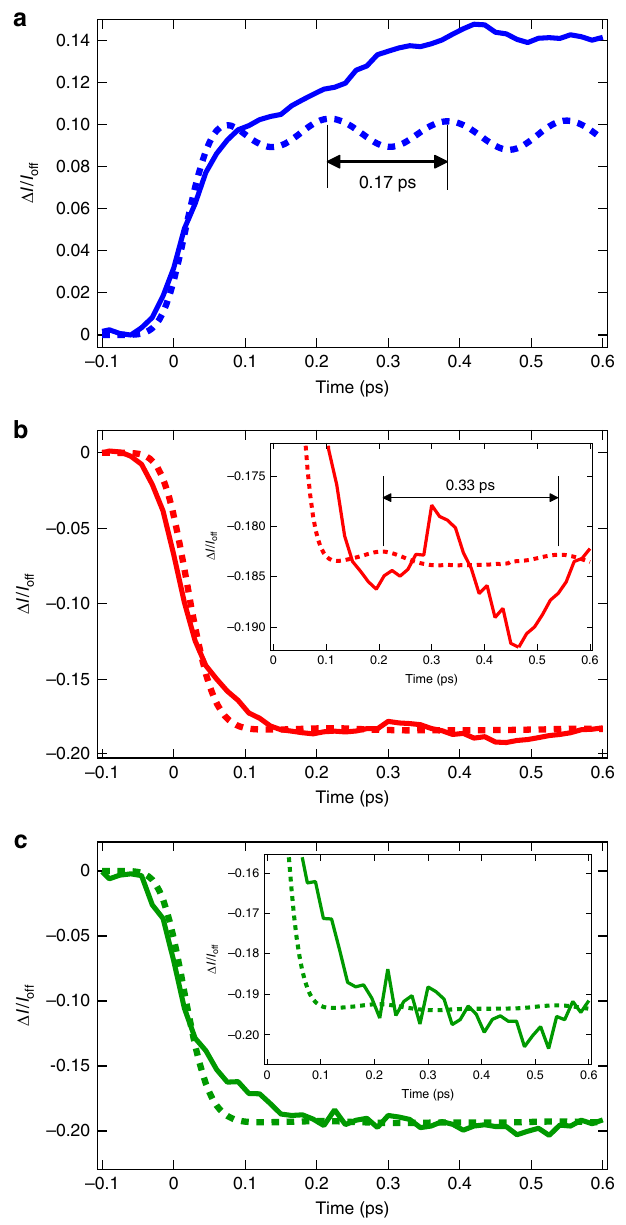
Fig. 5 Comparison between the experiment data and simulations. Transient spectra at a 8979.5 eV, at b 8985.0 eV, and at c 8986.5 eV as a function of the delay time. Insets of b , c are zooms into the weak oscillations. Solid line: experiment, dashed line: